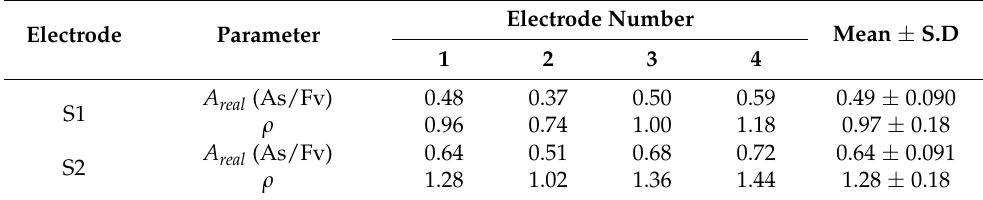
Table 1. The calculated A real and ρ using Equations (3) and (4) for the four different S1 and